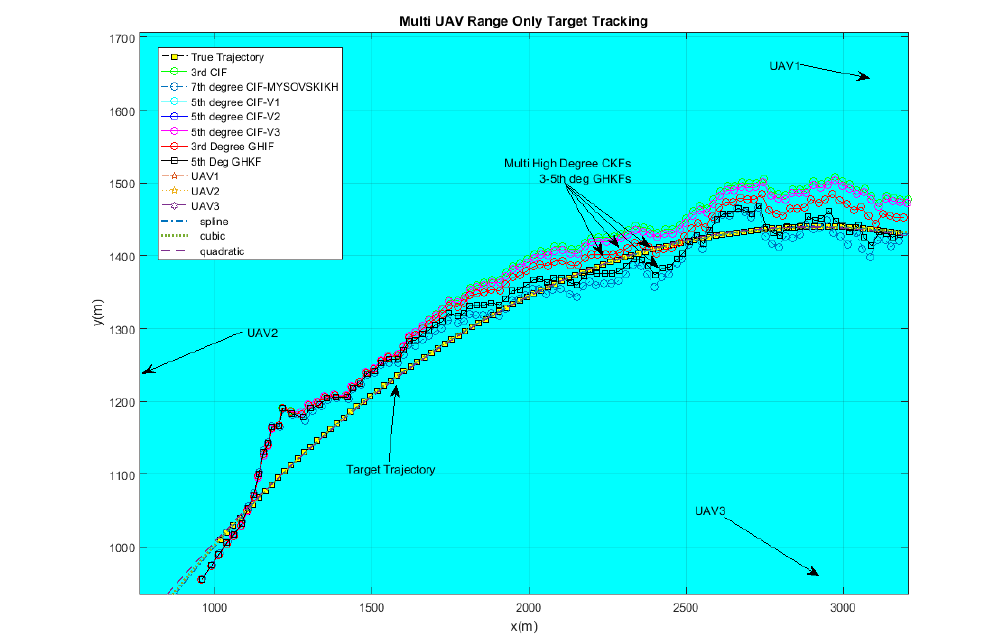
Figure 10. Zoom on range-only Doppler-based estimation: Results of 7 th -degree CIF, 5 th -degree CIF,